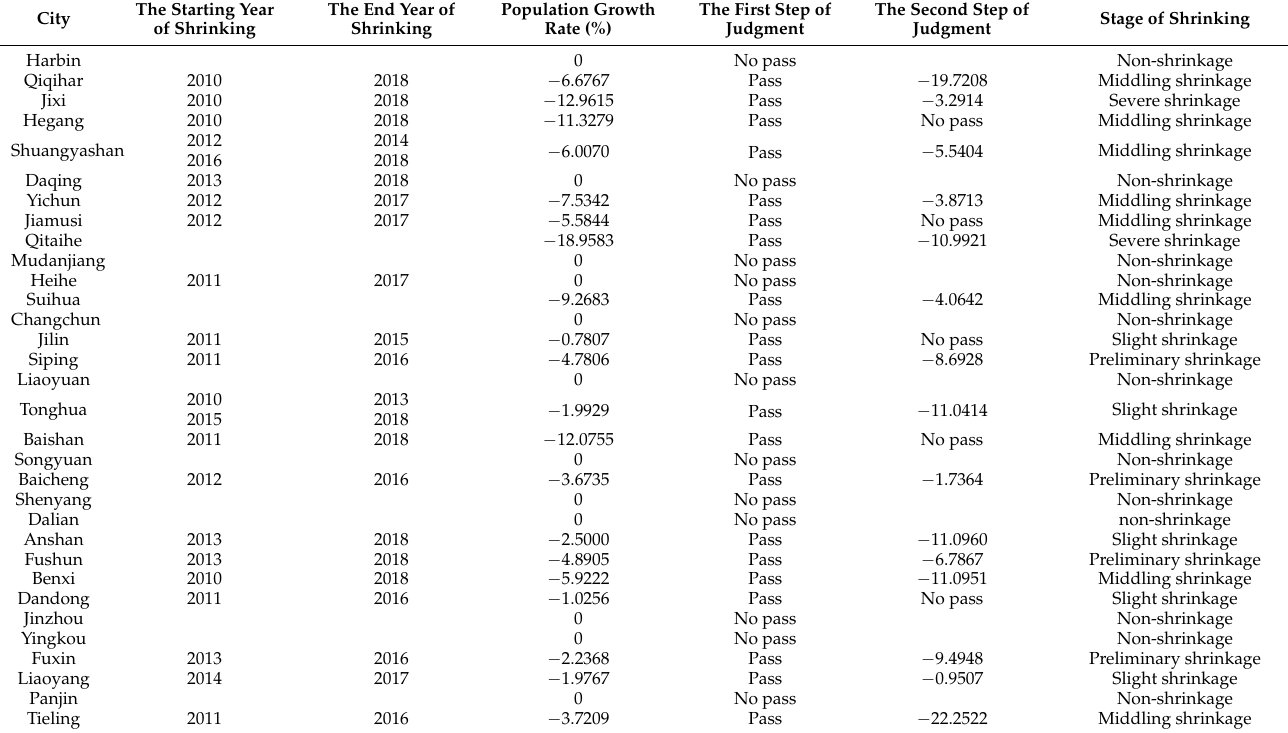
Table 4. Identification results of shrinking cities in three northeastern provinces of